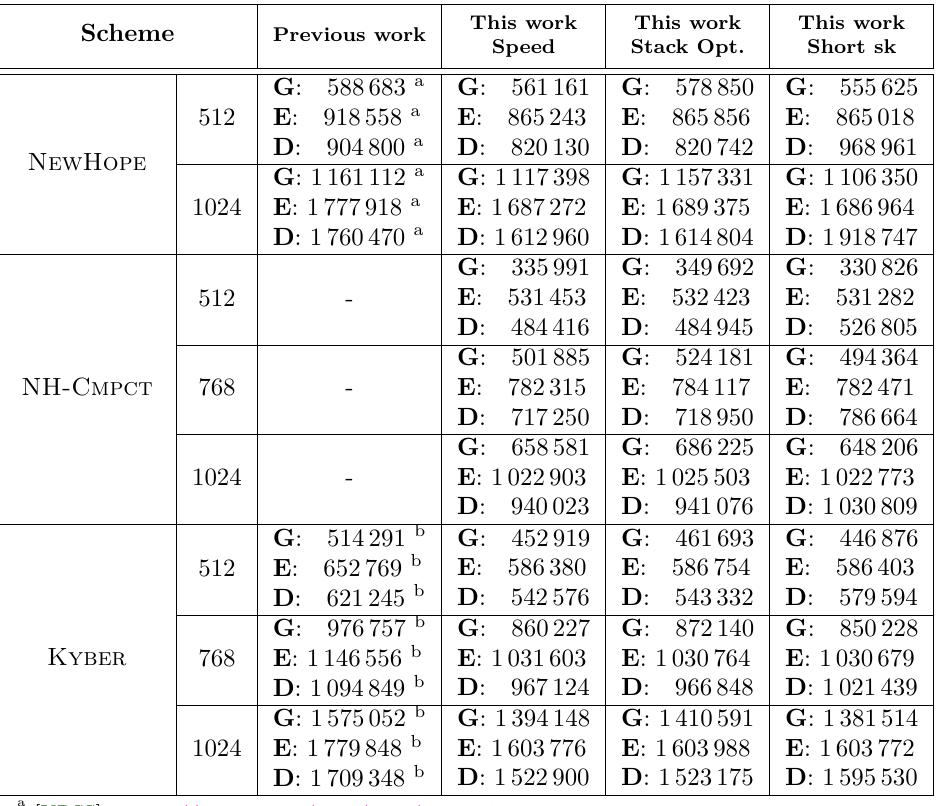
Table 3: Cycle count comparison for the {R,M}LWE schemes improved by our work. G : key generation, E : encapsulation, D :